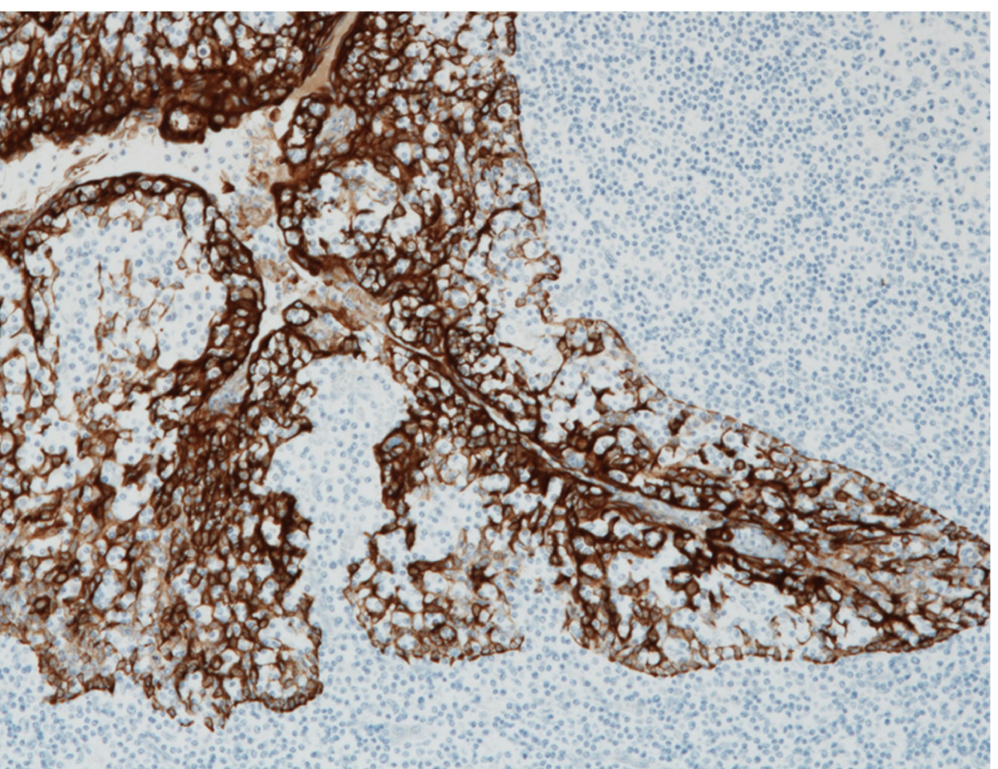
Figure 4. Lymphoepithelial symbiosis in palatine tonsils. The tonsillar crypt epithelium and tonsil parenchyma are mixed, which is called “lymphoepithelial symbiosis.” Reticular epithelial cells (cytokeratin positive brown cells)-fold lymphocytes (blue). Immunoperoxidase staining with anti- cytokeratin antibody (brown), original magnification ×